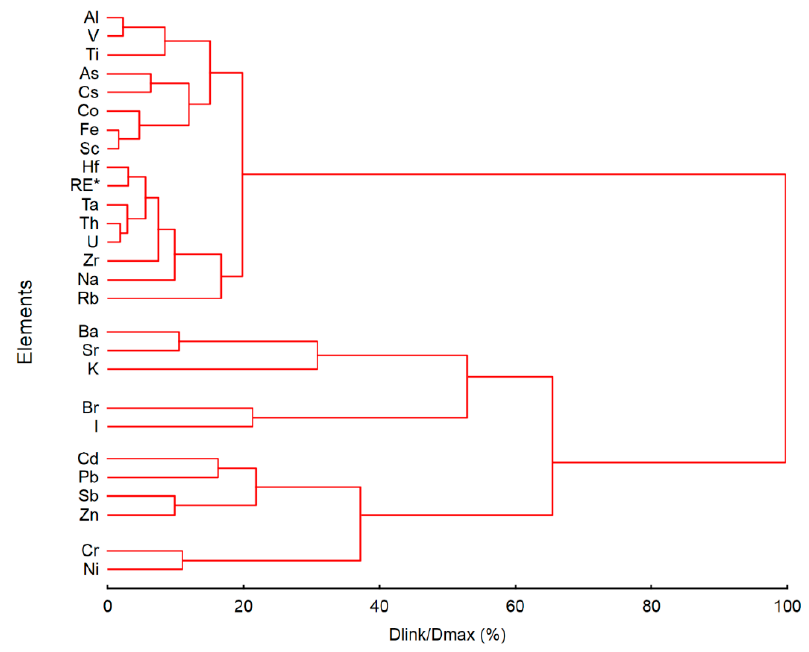
Figure 4. Cluster analysis dendrogram—element relationship ( n = 216, 27 selected elements). RE* — Average of the standardized values of analyzed rare-earth elements: Ce, Eu, La, Sm, and Tb.